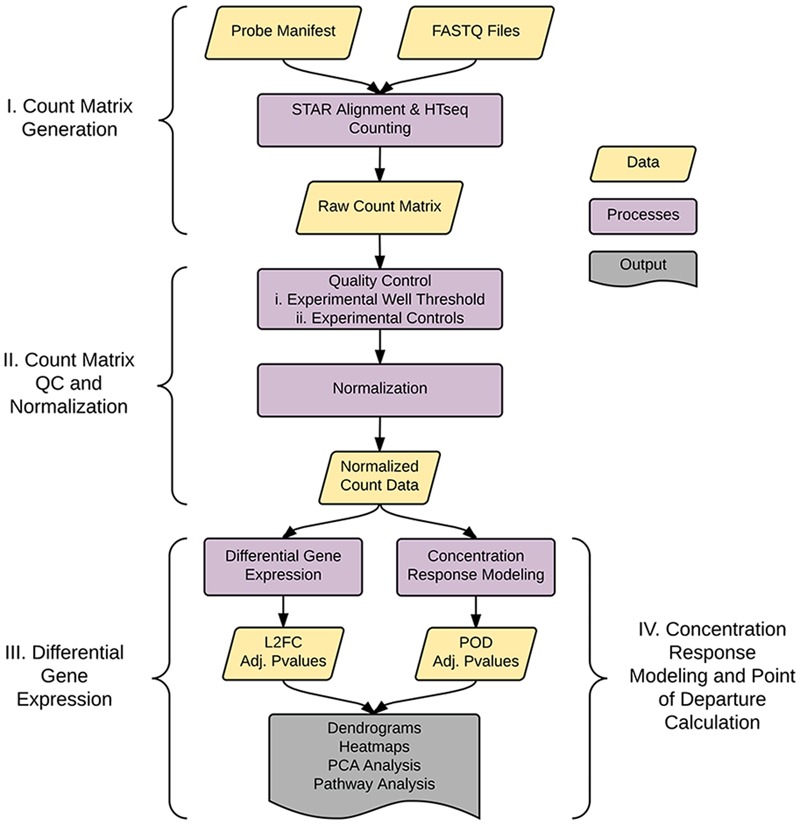
Pipeline overview. The pipeline consists of four major parts: I. Generation of the count matrix from sequenced reads, II. Quality-control and generation of normalized counts, III. Identification of differentially expressed genes (DEGs), and IV. Assessment of point of departure (POD) from count data.